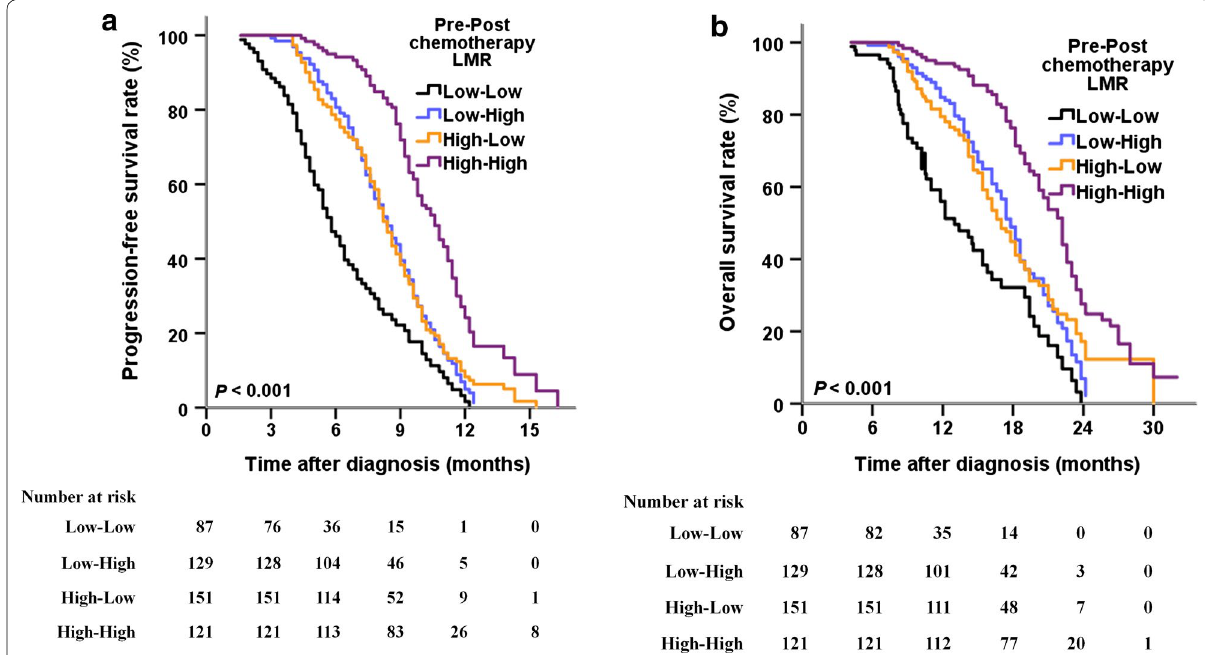
Fig. 2 Kaplan–Meier estimates of progression‑free and overall survival of patients with newly diagnosed metastatic colorectal cancer according to the changes in LMR before and after chemotherapy. a progression‑free survival, b overall